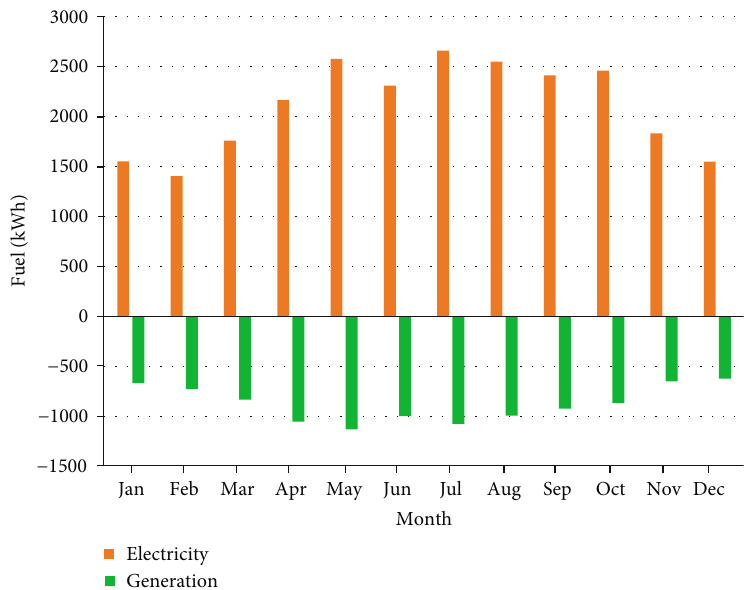
Figure 13: The total monthly consumed and produced load of the building with consideration of photovoltaic panel production.